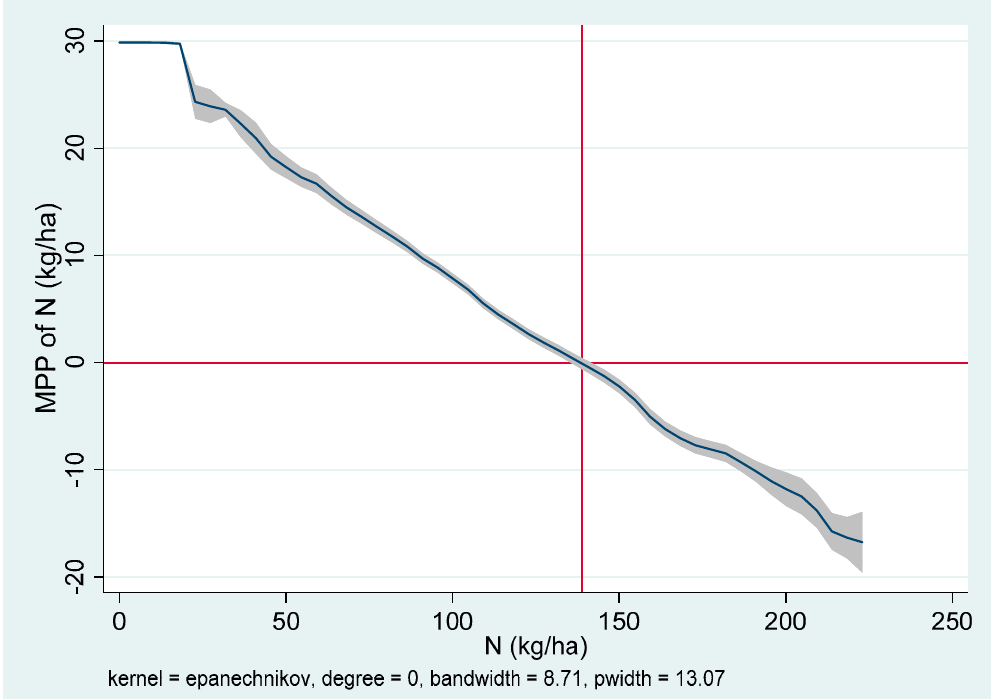
Figure 2. Marginal physical product of N at the mean level in Aduthurai, India.